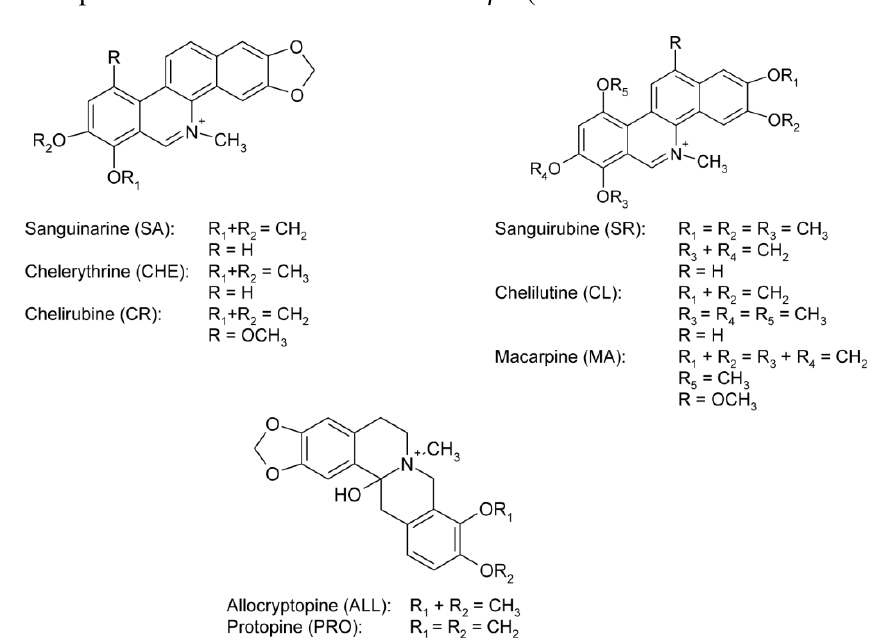
Figure 1. The isoquinoline alkaloids in M. microcarpa (all alkaloids are shown in cationic